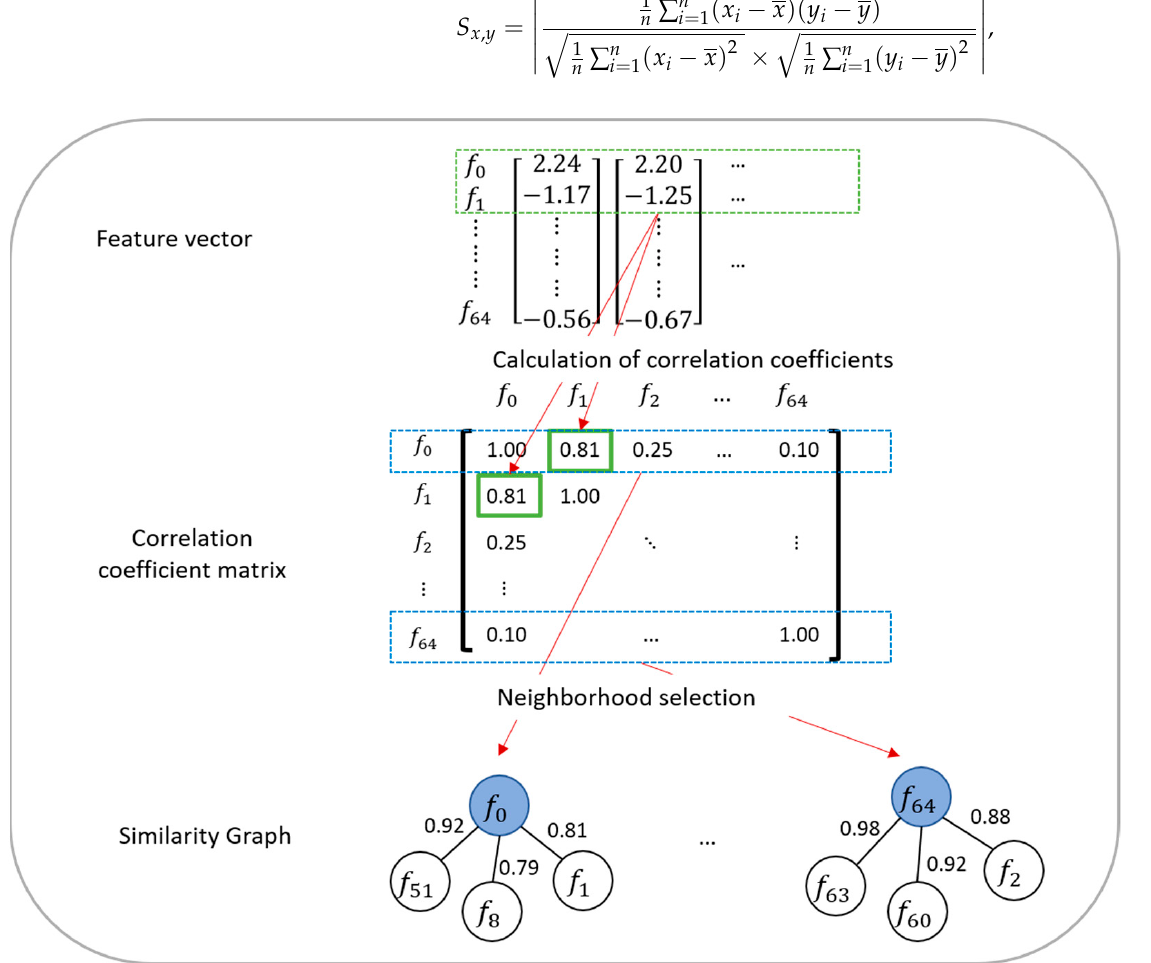
Figure 1. Schematic of similarity graph generation.